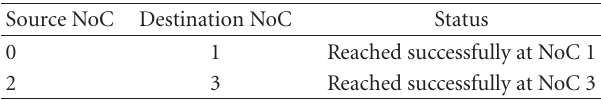
Table 18: The payload successfully reached to its desired destina- tion